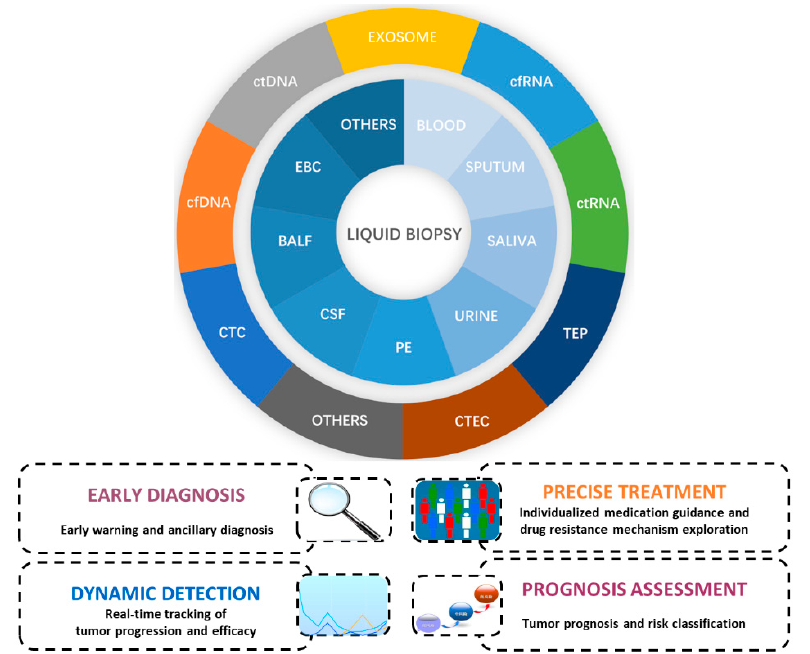
Figure 1. The great potential and broad prospects for the clinical application of liquid biopsy in NSCLC diagnosis and treatment. Abbreviations: PE, pleural effusion; CSF, cerebrospinal fluid; BALF, bronchoalveolar lavage fluid; EBC, exhaled breath condensate; ctDNA, circulating tumor DNA; cfDNA, circulating free DNA; CTC, circulating tumor cells; cfRNA, circulating free RNA; ctRNA, circulating tumor RNA; TEP, tumor-educated platelets; CTEC, circulating tumor endothelial cell.